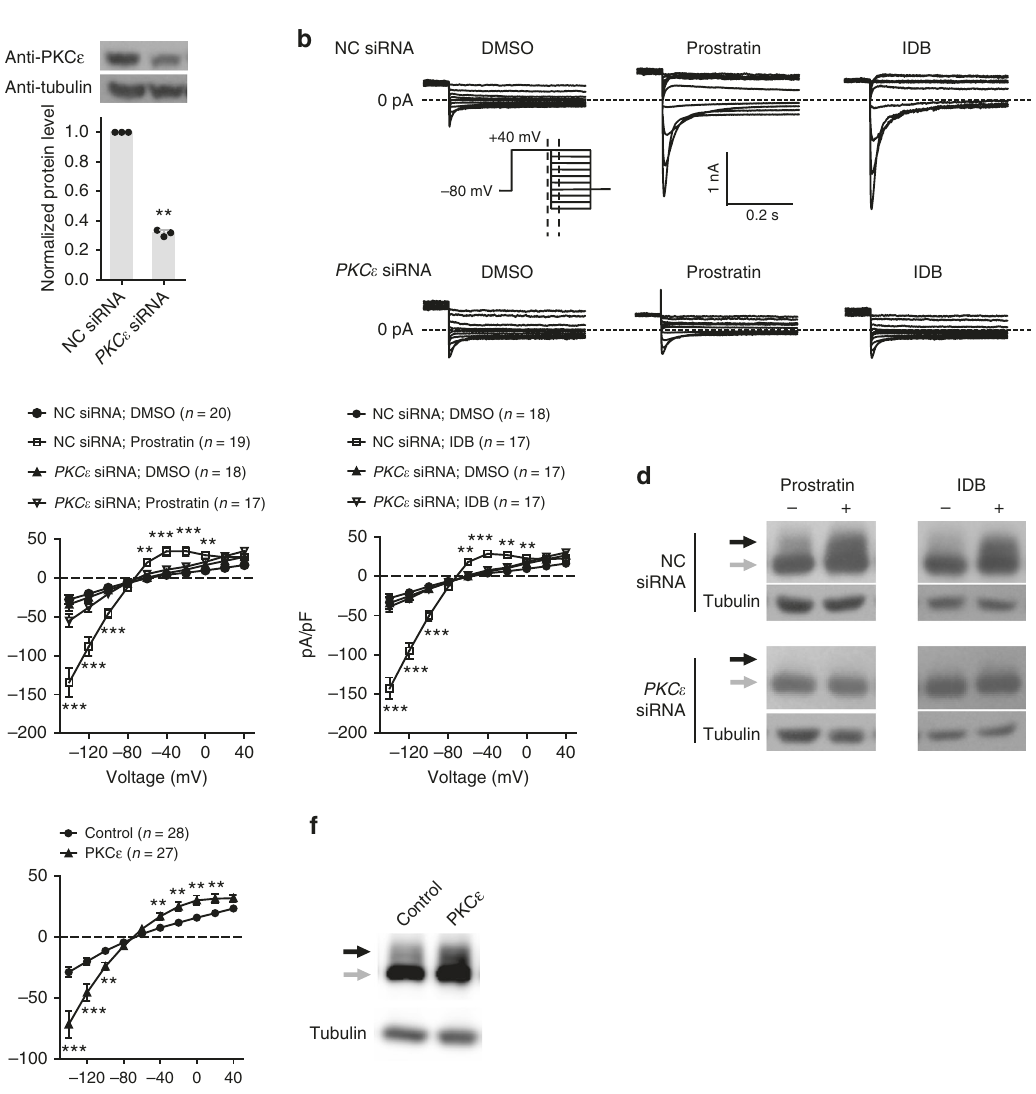
Fig. 4 The action of Prostratin and IDB requires activation of PKC ε signaling. a The ef fi ciency of siRNAs targeting PKC ε . A scrambled siRNA was used as a negative control (NC). b , c Effects of Prostrain and IDB on whole-cell currents ( b ) and current densities ( c ) of hERG WT -hERG A561V channels expressed in HEK293T cells treated with control or PKC ε siRNAs. d Effects of Prostrain and IDB on protein traf fi cking of hERG WT -hERG A561V channels expressed in HEK293T cells treated with control or PKC ε siRNAs. e , f Effects of PKC ε over-expression on current densities ( e ) and protein traf fi cking ( f ) of hERG WT - hERG A561V channels expressed in HEK293T cells. Black and gray arrows indicate 155 kD and 135 kD bands of hERG proteins, respectively. The ratio of hERG WT /hERG A561V was 2:1 for b , c , e , and 1:1 for d , f . All experiments were performed at least three times. Data shown are mean ± s.e.m. ** P < 0.01, *** P < 0.001 (one-way ANOVA Dunnett ’ s test for c , Student ’ s t -tests for a , e